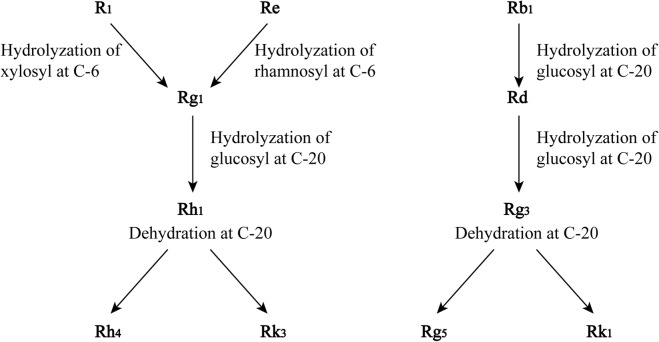
Proposed transformation of saponins in the process of steaming of notoginseng. Adopted from Wang et al. (2012).